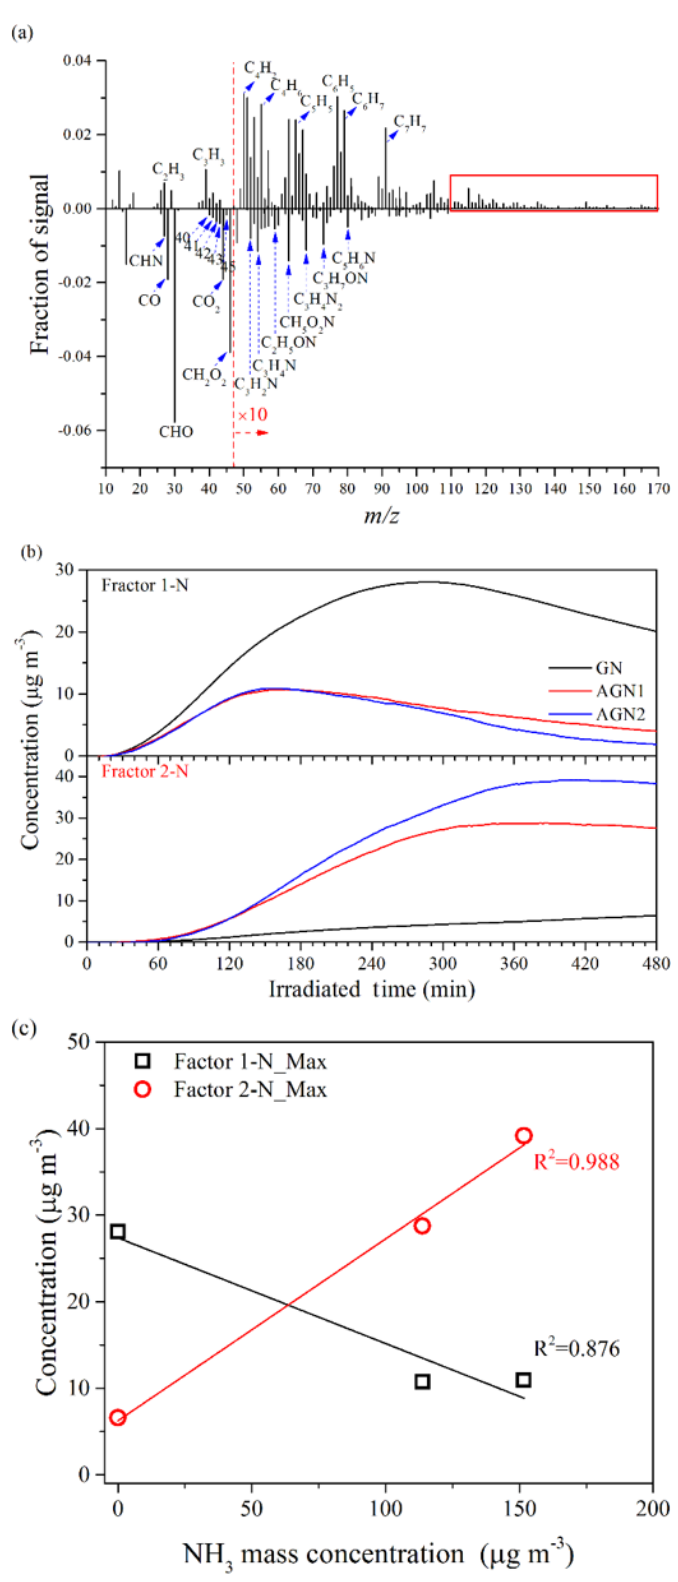
Figure 10. (a) Different mass spectra (Factor 1-N–Factor 2-N) between the two factors, (b) time series of the mass concentration, and (c) relationship between the concentration of NH 3 and the maximum concentration of the two factors identified by applying PMF analysis to the AMS data derived from the experiments at different concentrations of NH 3 (Exps. GN, AGN1, and